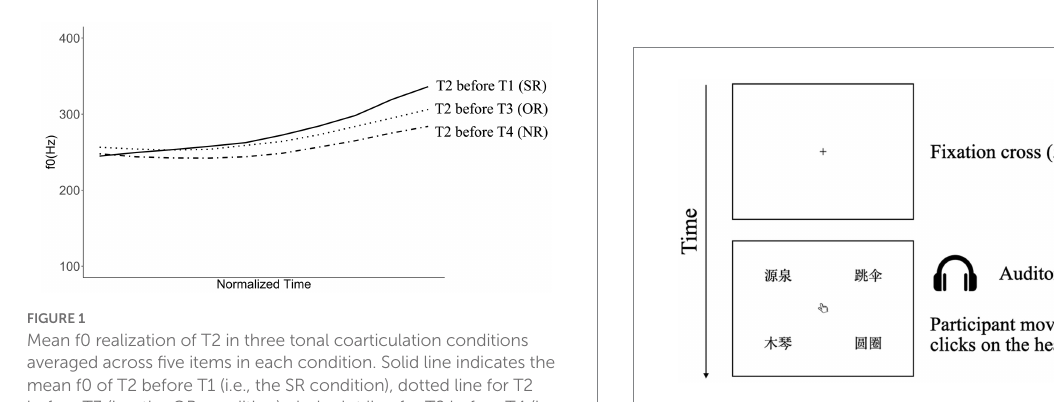
FIGURE 2 The procedure of the auditory and visual stimuli